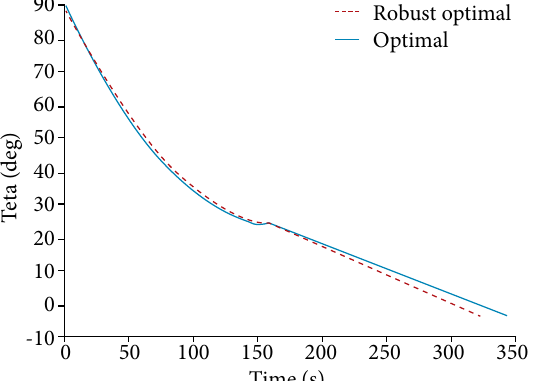
Figure 14. Comparison of pitch angle in optimal and robust optimal.